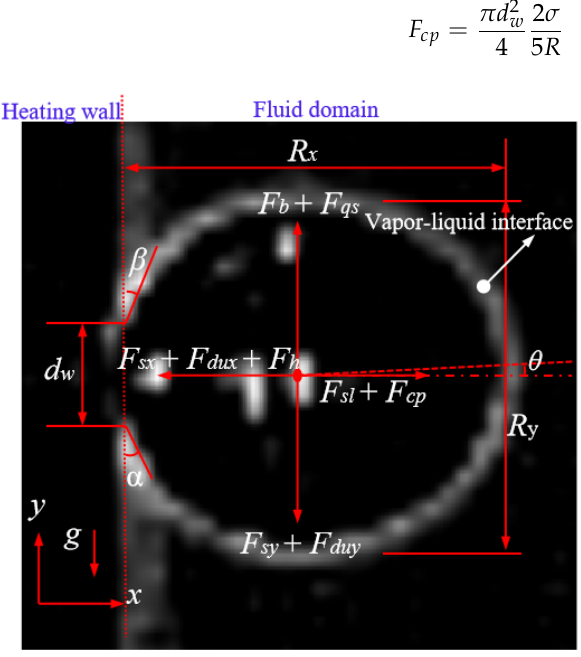
Figure 6. Force analysis of bubbles.